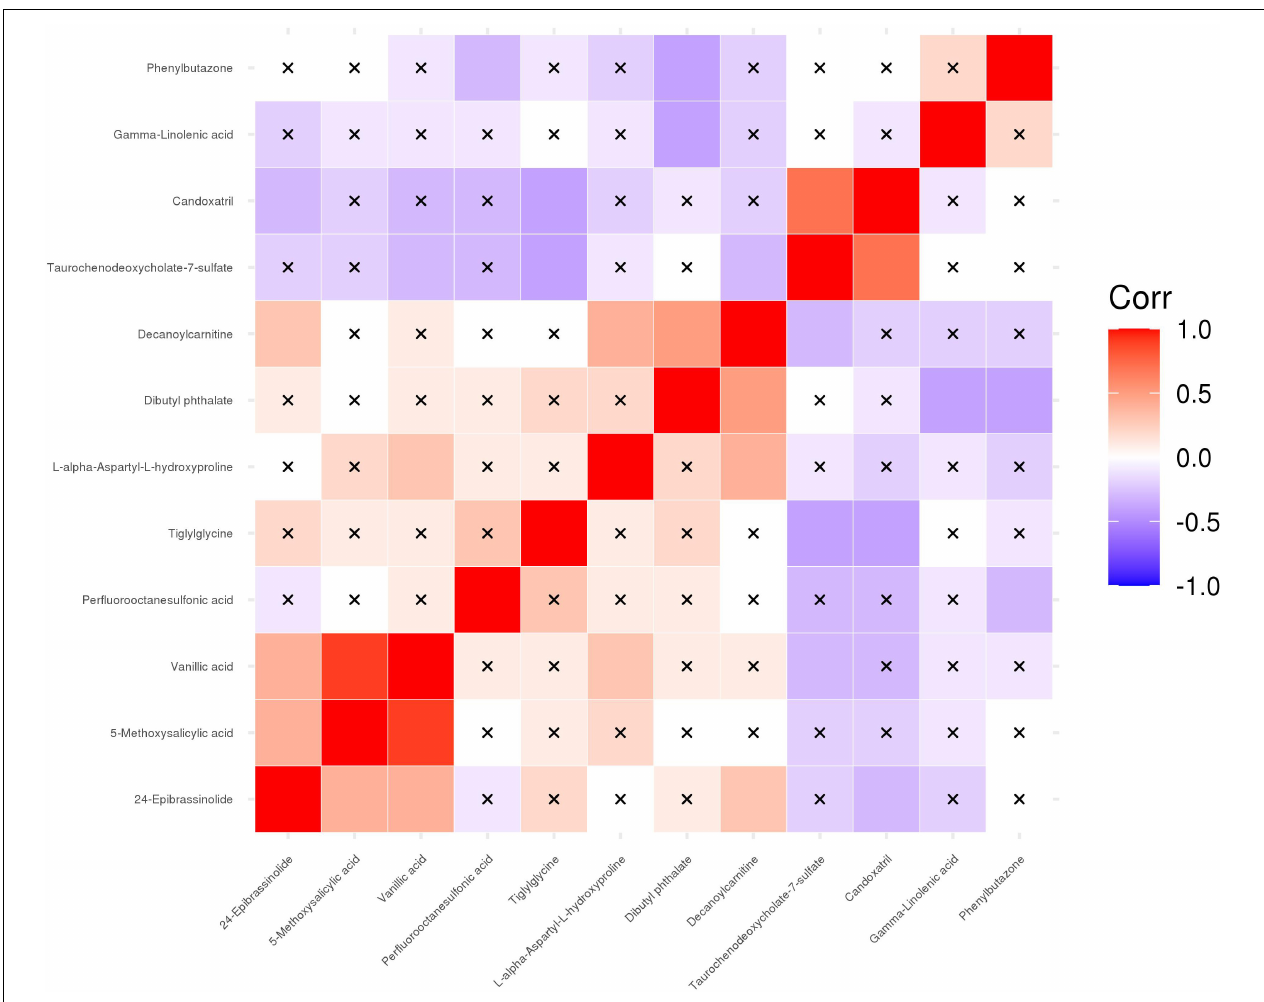
FIGURE 5 | Correlation analyses of differential metabolites between the EA group and the non-EA group. 12 altered metabolites listed in Table 3 were performed Pearson correlation analyses using a heat map. The positive and negative correlations were shown in red and blue, respectively. A cross mark indicated a non-significant